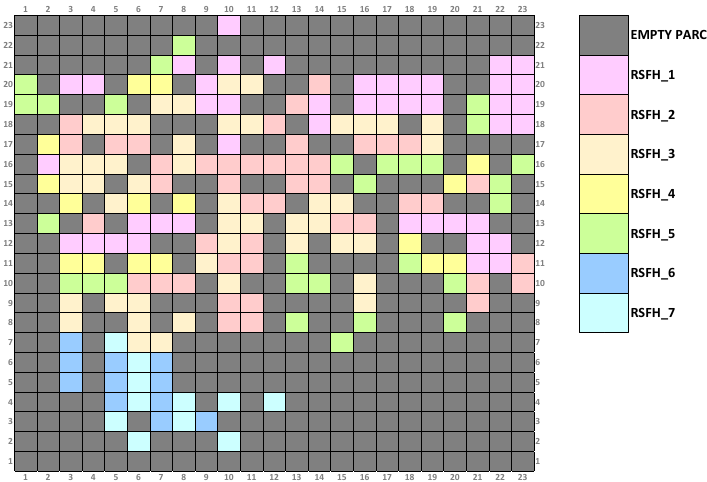
Figure 7. The final schema of the Smulsko cluster for the analysis in the TEAC software.